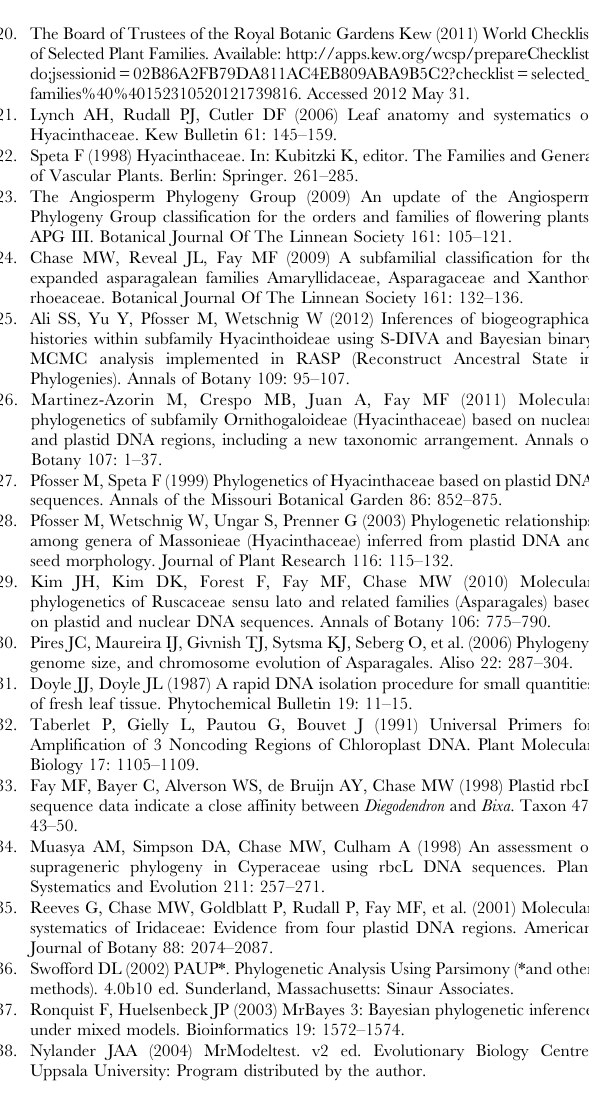
Figure S3 Biogeographical reconstruction of Hyacintha- ceae using Lagrange and displayed on the PL-dated allcompat tree. A) overview of the family with the 95% confidence intervals on divergence time estimates indicated on